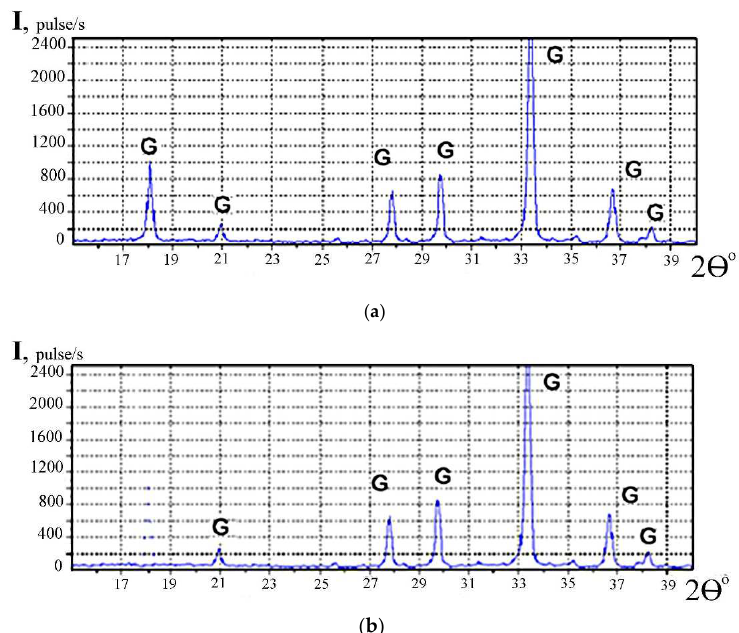
Figure 8. ( a ) XRD pattern of aerosol powders of YAG, heated at 1000 °C; ( b ) XRD patterns of compact sample, sintered aerosol powders of made of a working solution with additive of urea portion. Marking «G»–YAG.